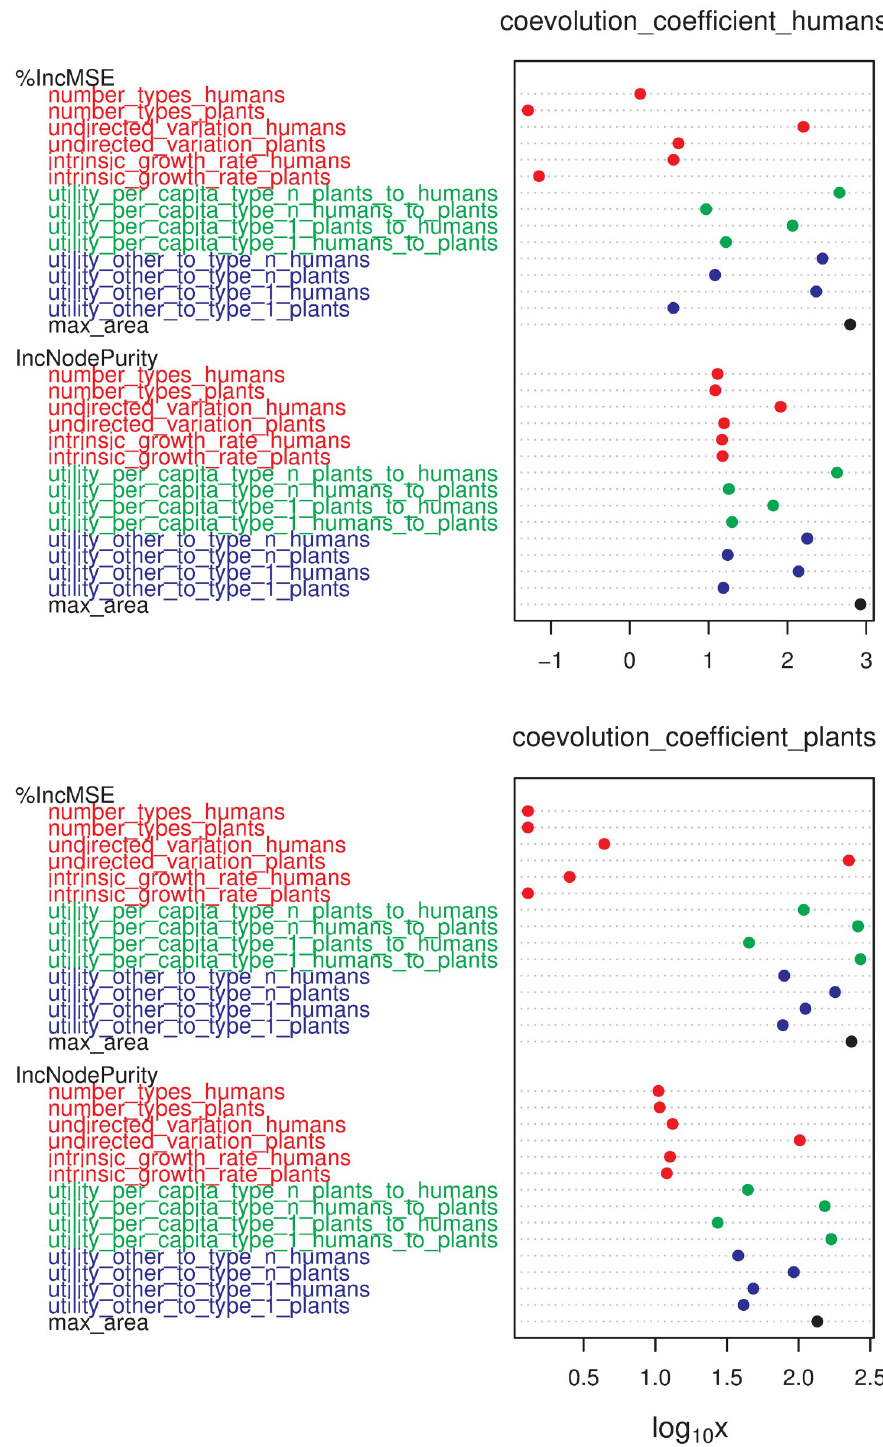
Fig 7. The importance of parameters measured as a percentage of mean squared error increase (%IncMSE) and total decrease in node impurities (IncNodePurity) obtained by fitting Random Forest Regression models where parameters are inputted as predictors of the human (left) and plant (right) coevolution coefficients; for similar applications, see [69, 70]. The number of trees and number of sampled variables were optimized by a standard 10-fold cross-validation procedure